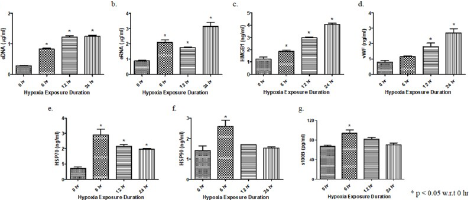
Fig 1. AH induces release of circulating nucleic acids and expression of sterile inflammatory protein molecules. Level of SI markers in plasma was analysed after exposure to hypoxia for different time durations (0–24 hrs); (a) eDNA ( μ g/ml), (b) eRNA ( μ g/ml), (c) HMGB1 (ng/ml), (d) vWF (ng/ml), (e) HSP70 (ng/ml), (f) HSP90 (ng/ml), and (g) s100b (pg/ml). Data are shown as mean ± SEM (n = 5/group/each time point) from one experiment representative of three independent experiments, all performed in triplicate. One-way ANOVA revealed statistical significance in the results ( � p <